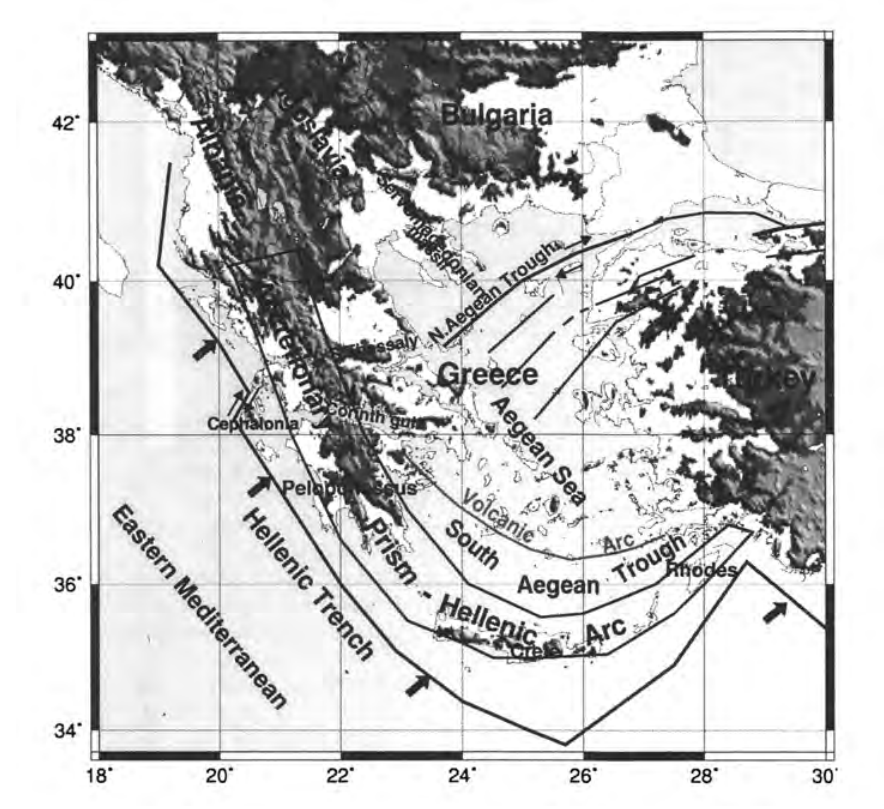
Figure 1. The main morphotectonic characteristics of the broader area of Greece [after Papazacos et al. 1998].